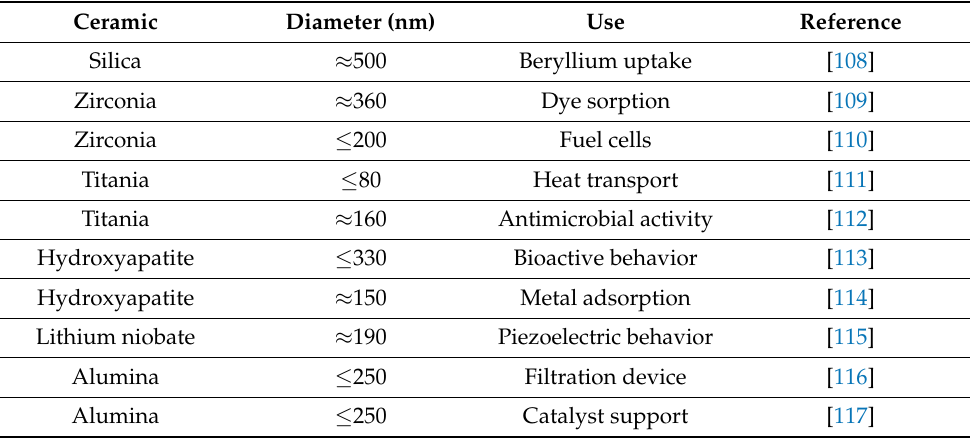
Figure 6. ZrO 2 fibers for dye capture ( a ) and hydroxyapatite–glass fibers for metal adsorption ( b ). Table 3. Ceramics used in electrospinning for nanofiber obtainment.